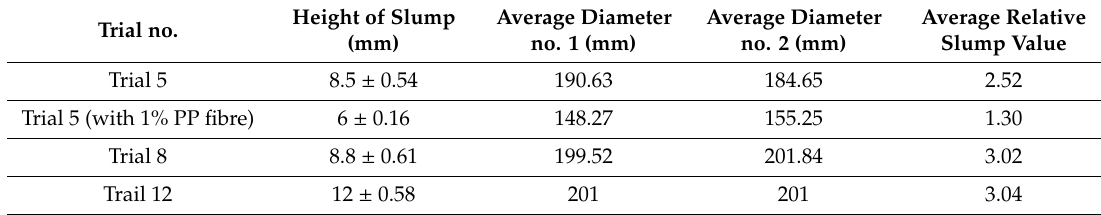
Table 4. The relative slump value and height of the slump for selected trials.